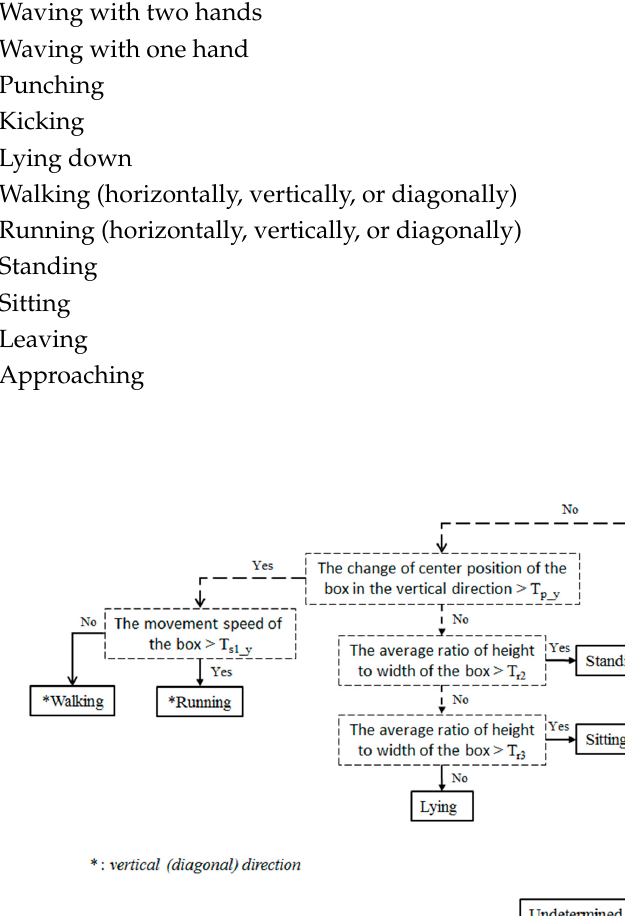
Figure 3. Flowchart of the proposed method of behavior recognition.